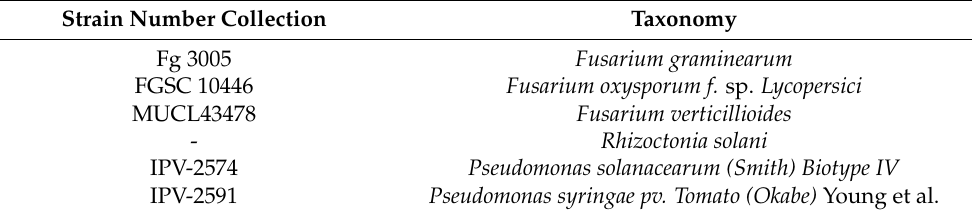
Table 2. Fungal and bacterial strains used in this work. Fg3005 was kindly provided by D. Gardiner. FGSC= Fungal Genetics Stock Center; MUCL = Mycoth è que de l’Universit é catholique de Louvain; IPV = Istituto Patologia Vegetale di